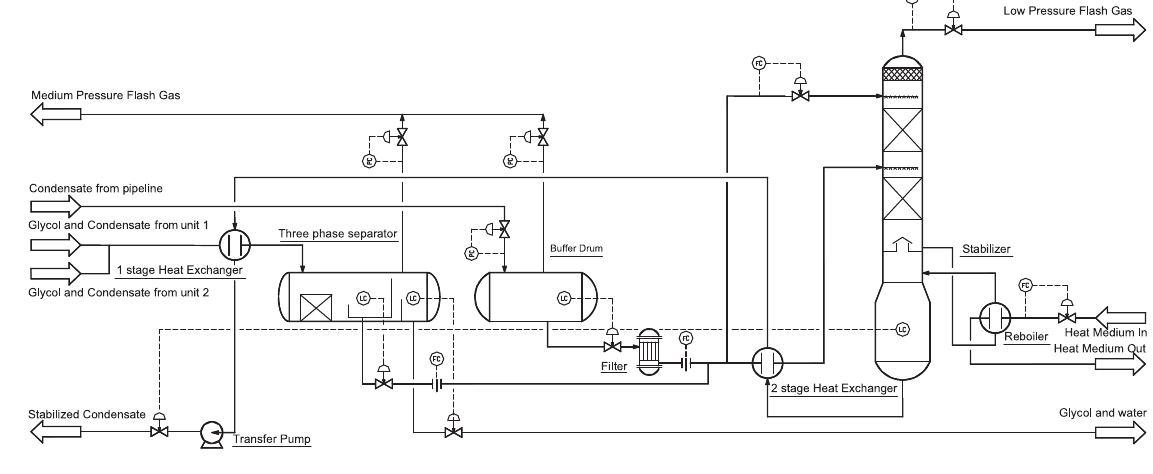
Fig. 6. The condensate stabilization unit fl ow diagram. Three-phase separator: Operation pressure: 1.5 MPa.g; Operation temperature: 50 (cid:3) C; Buffer drum: Operation pressure: 1.0 MPa.g; Operation temperature: 50 (cid:3) C; Stabilizer: Operation pressure: 0.4 MPa.g; Operation temperature: 140 (cid:3) C (bottom of stabilizer), 83 (cid:3) C (top of